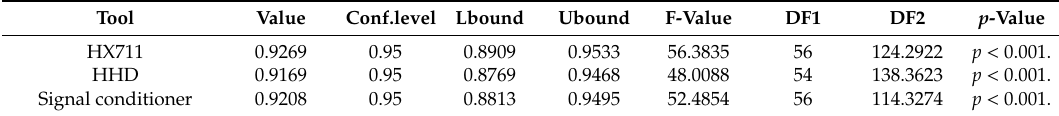
Table 5. Session one results of ICC calculation comparing each participant’s MVIC trials among themselves for each instrument and their 95% confident intervals, using a single-rating, absolute-agreement, 2-way mixed-effects model.